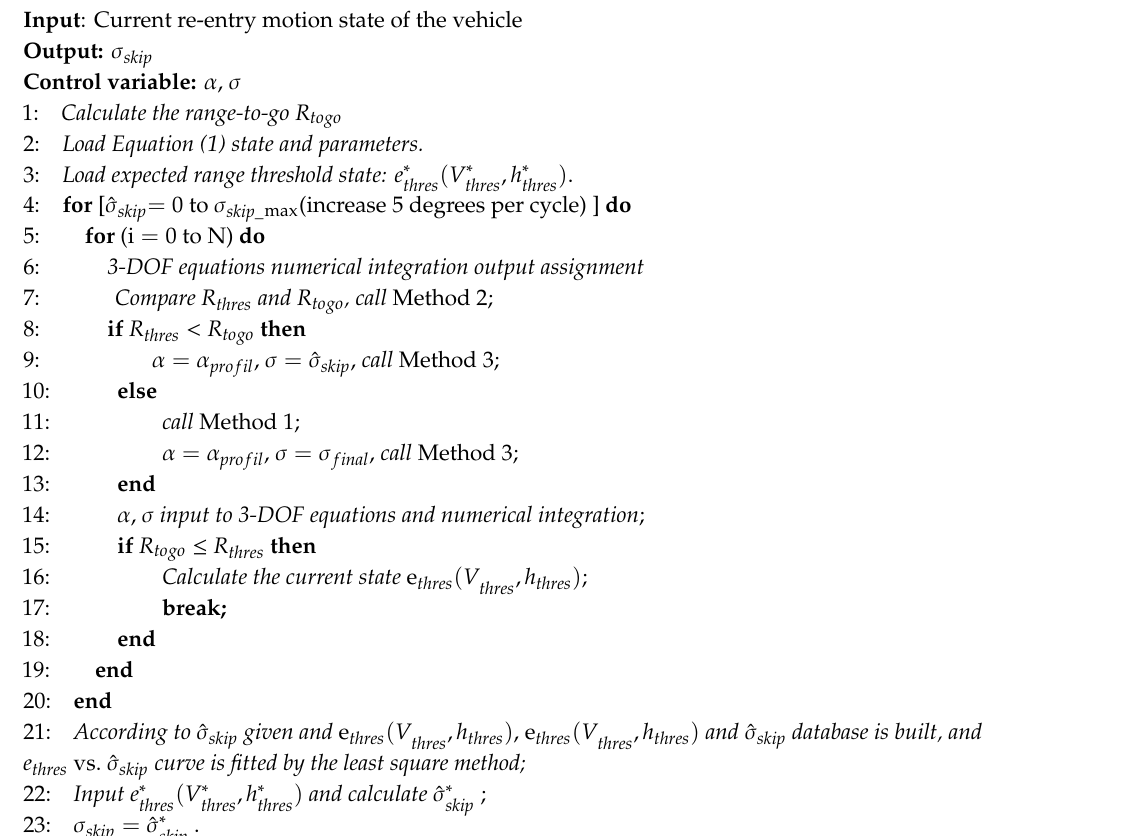
Algorithm 1. The motion model-based σ skip numerical search